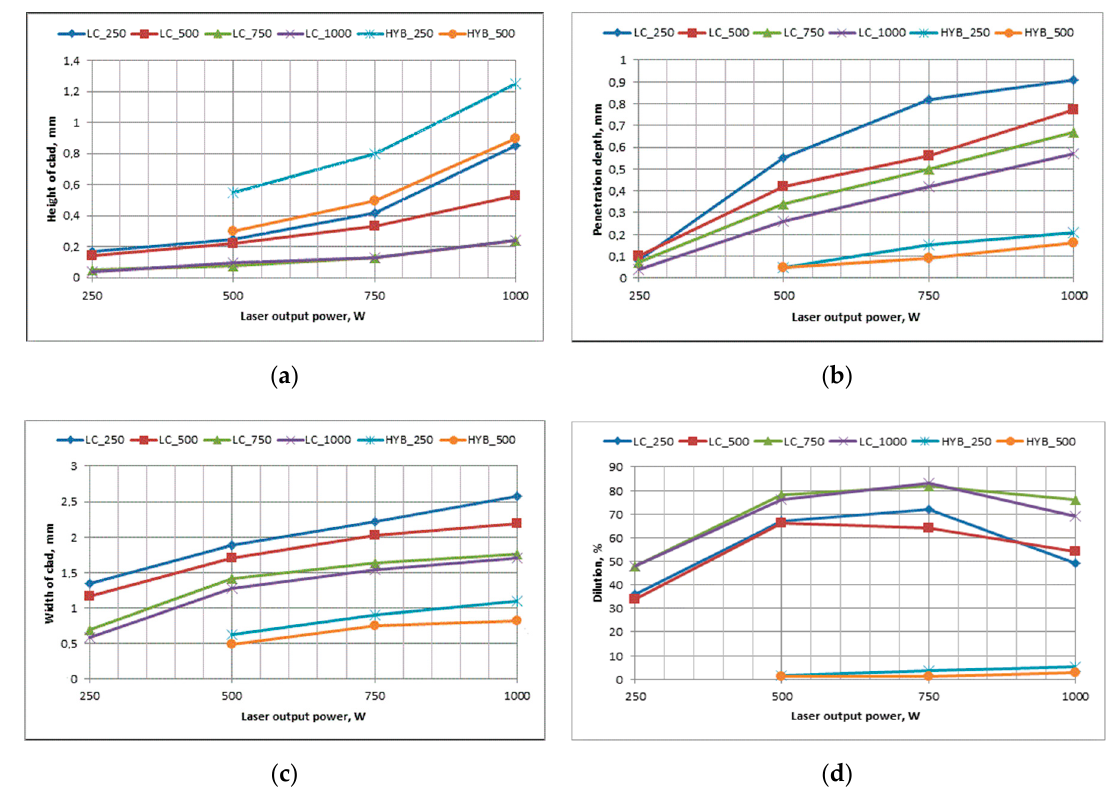
Figure 9. Influence of the process parameters and cooling conditions on the geometry and dimensions of the stringer beads produced by laser deposition of Fe-based powder (Tables 3 and 4): ( a ) height of the clad (reinforcement); ( b ) penetration depth into the substrate; ( c ) width of the single clad layer; and ( d ) calculated rate of dilution.